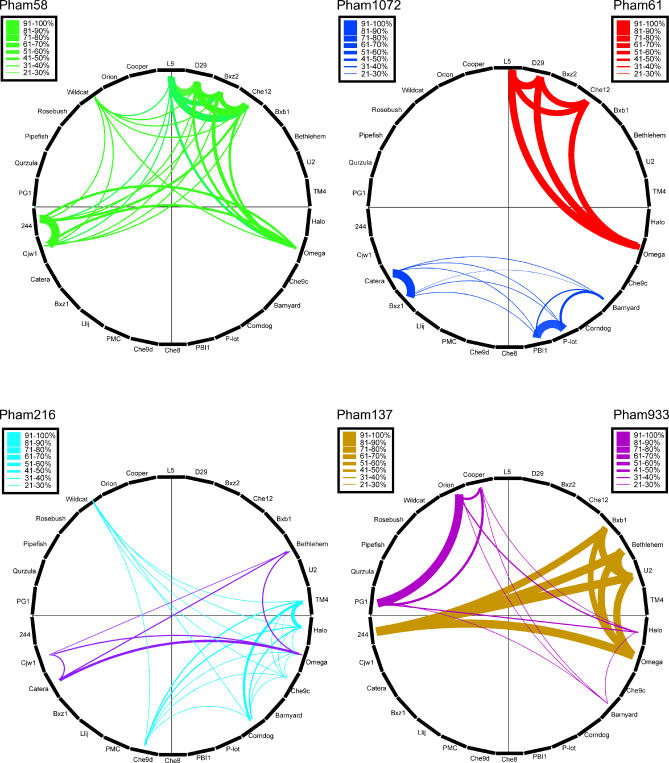
Phamily Circle Representations of Phamily RelationshipsAll 30 genomes are shown around the circumference, and the phamily members are linked by a line with the width representing the degree of similarity. Phamily circles of Pham58 (upper left), Pham61 and Pham1072 (upper right), and Pham137 and Pham993 (lower right) are shown using different colors for different Phams. Pham216 (bottom left) is shown in turquoise, with the intein present within the Omega phamily member (which has a different set of relationships) shown in purple.